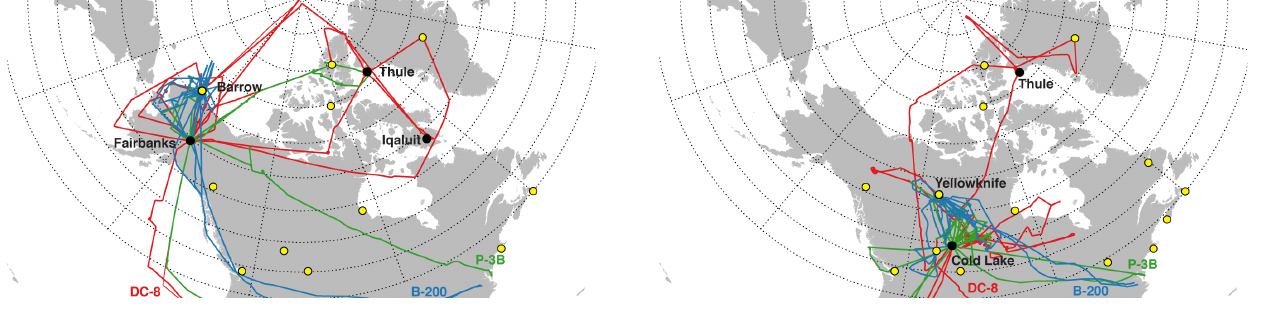
Figure 1a. Flight tracks for the ARCTAS-A spring deployment (Table 4a-c). Yellow circles are ozonesonde launch sites (Table 3d) Fig. 1a. Flight tracks for the ARCTAS-A spring deployment (Ta- ble 4a–c). Yellow circles are ozonesonde launch sites (Table 3d)